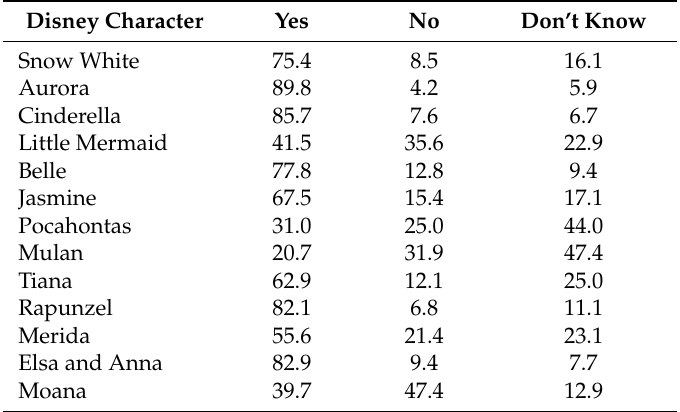
Table 2. Response percentages for princesses presented during study manipulation